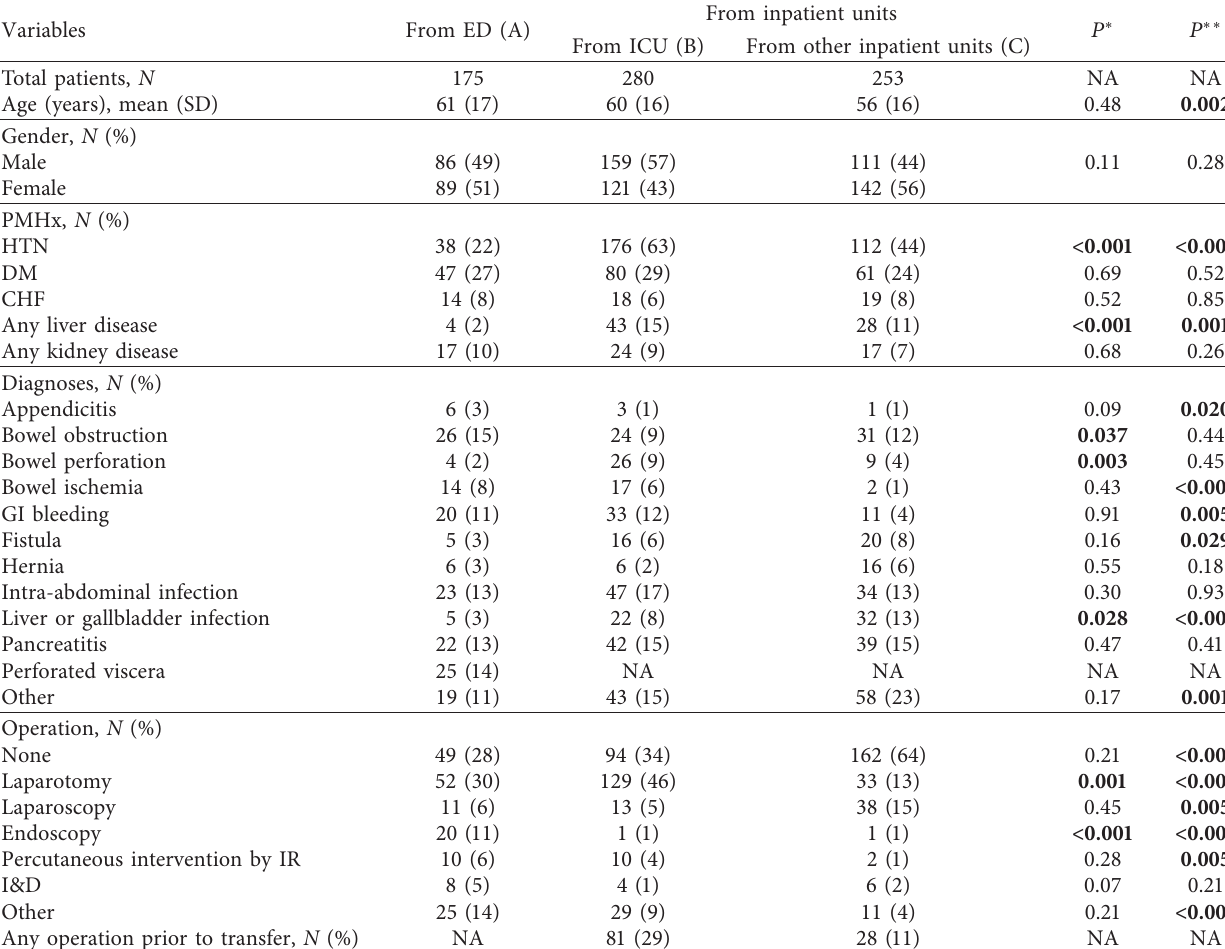
Table 2: Demographic and clinical characteristics of patients admitted to EGS from the ED and inpatient